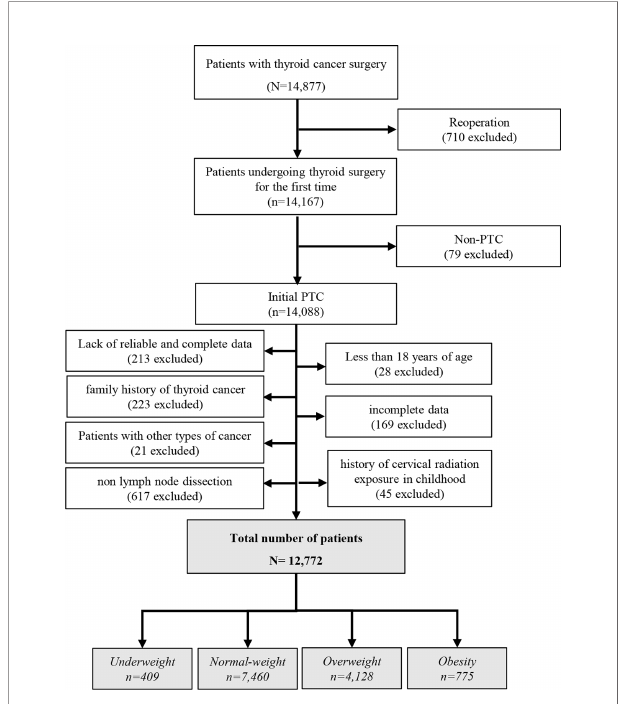
FIGURE 1 | Flow chart of study inclusion and exclusion